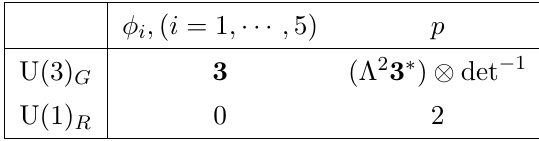
Table 3 . The matter contents of equivariant A-twisted GLSM for X 3 ; 5